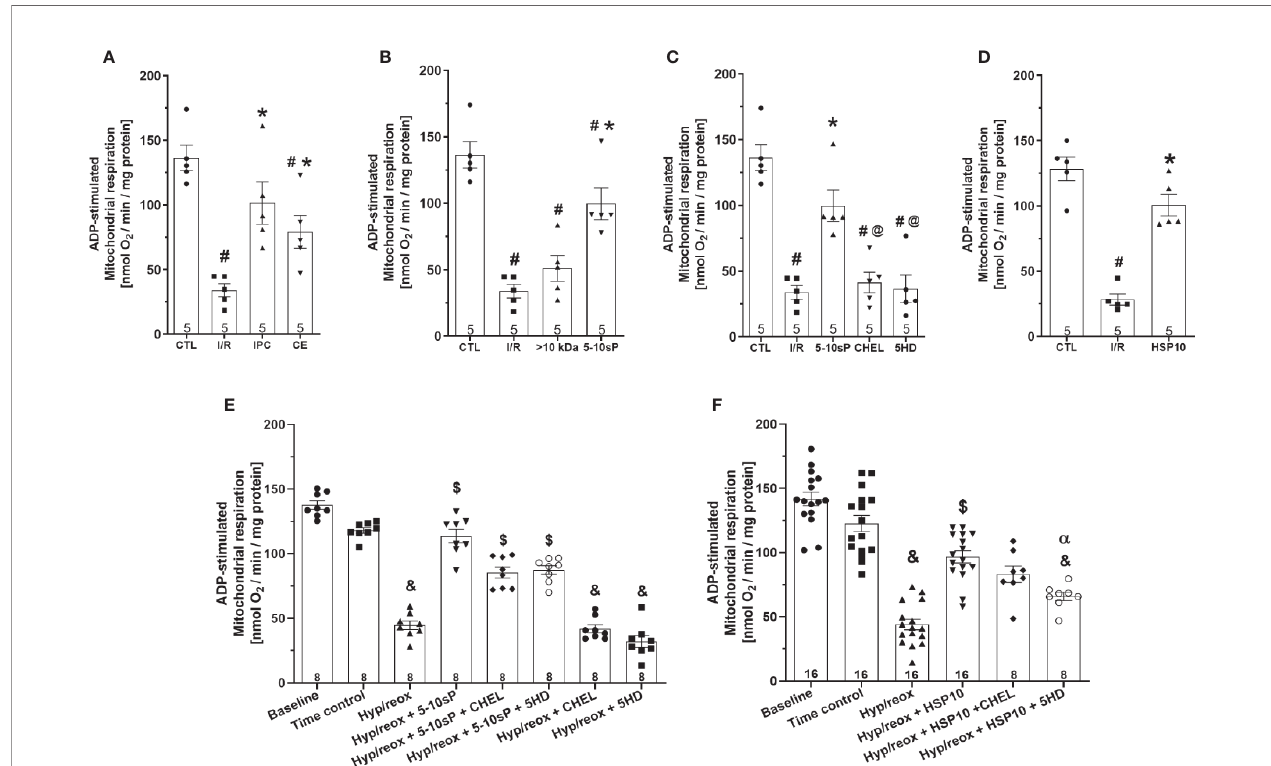
FIGURE 2 | Adenosine diphosphate (ADP)-stimulated complex I respiration of isolated mitochondria from rat hearts. (A – D) Isolated mitochondria from hearts submitted to I/R. Control (CTL), ischemia/reperfusion (I/R), ischemic preconditioning (IPC), preconditioned coronary ef fl uent transfer (CE), coronary ef fl uent fraction 5 – 10 kDa (5 – 10-sP) transfer, coronary ef fl uent fraction >10 kDa (> 10 kDa) transfer, 5 – 10-sP plus PKC inhibitor chelerythrine or mitochondrial K ATP channel blocker 5HD. (E , F) Isolated mitochondria from hearts submitted to I/R under 10 kDa-mitochondrial heat shock protein (HSP10) perfusion. Mitochondria respiration submitted to hypoxia/reoxygenation and (F) HSP10 or (E) 5 – 10-sP with or without chelerythrine or 5HD incubation. Number in each column is n of hearts. # P < 0.05 vs . CTL, *P < 0.05 vs . I/R, @ P < 0.05 vs . 5 – 10-sP, & P < 0.05 vs . Time control, $ P < 0.05 vs . hypoxia/reoxygenation. a P < 0.05 vs . hypoxia/reoxygenation +